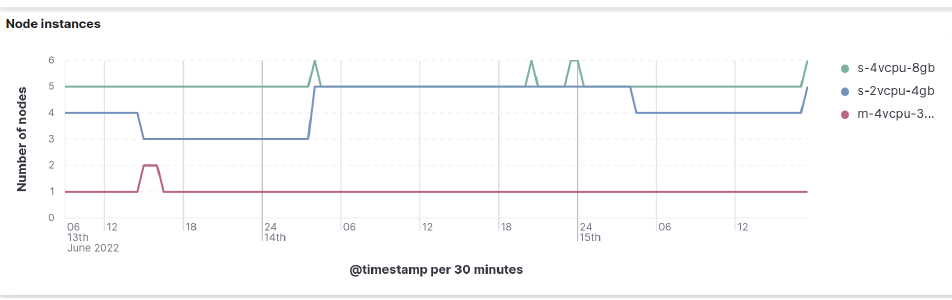
Figure 8. Node instance count in the production